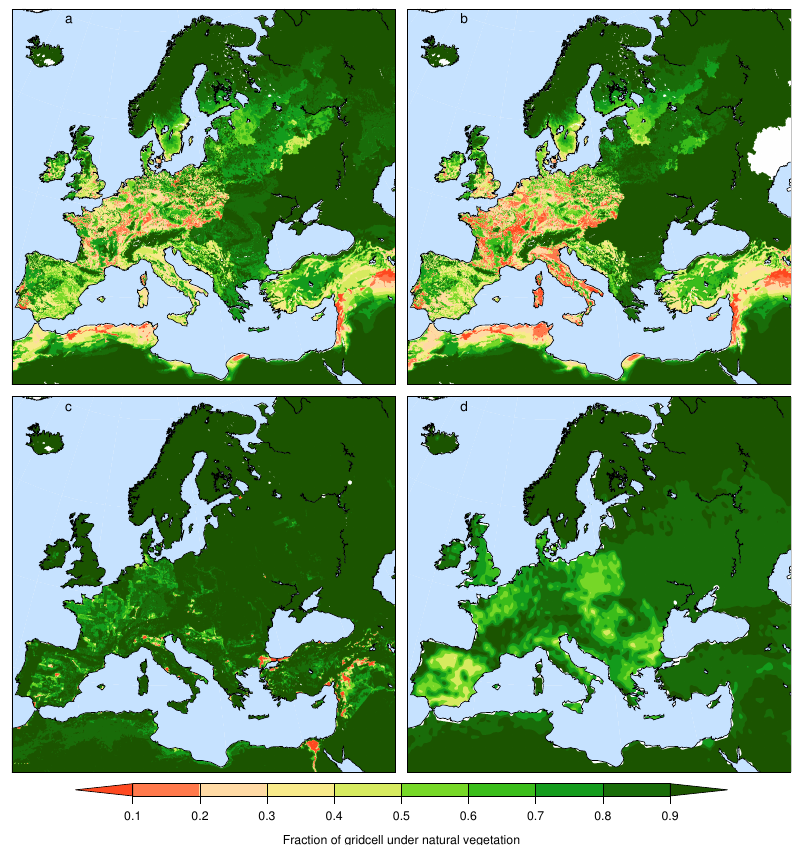
Fig. 4. Anthropogenic land use in Europe and surrounding areas at AD 800 simulated by four different modelling approaches: (a) , the Kaplan et al. (2009) standard scenario; (b) , the Kaplan et al. (2009) technology scenario; (c) , the HYDE [History Database of the Global Environment] database version 3.1 (Klein Goldewijk et al., 2010); (d) , the Pongratz et al. (2008) maximum